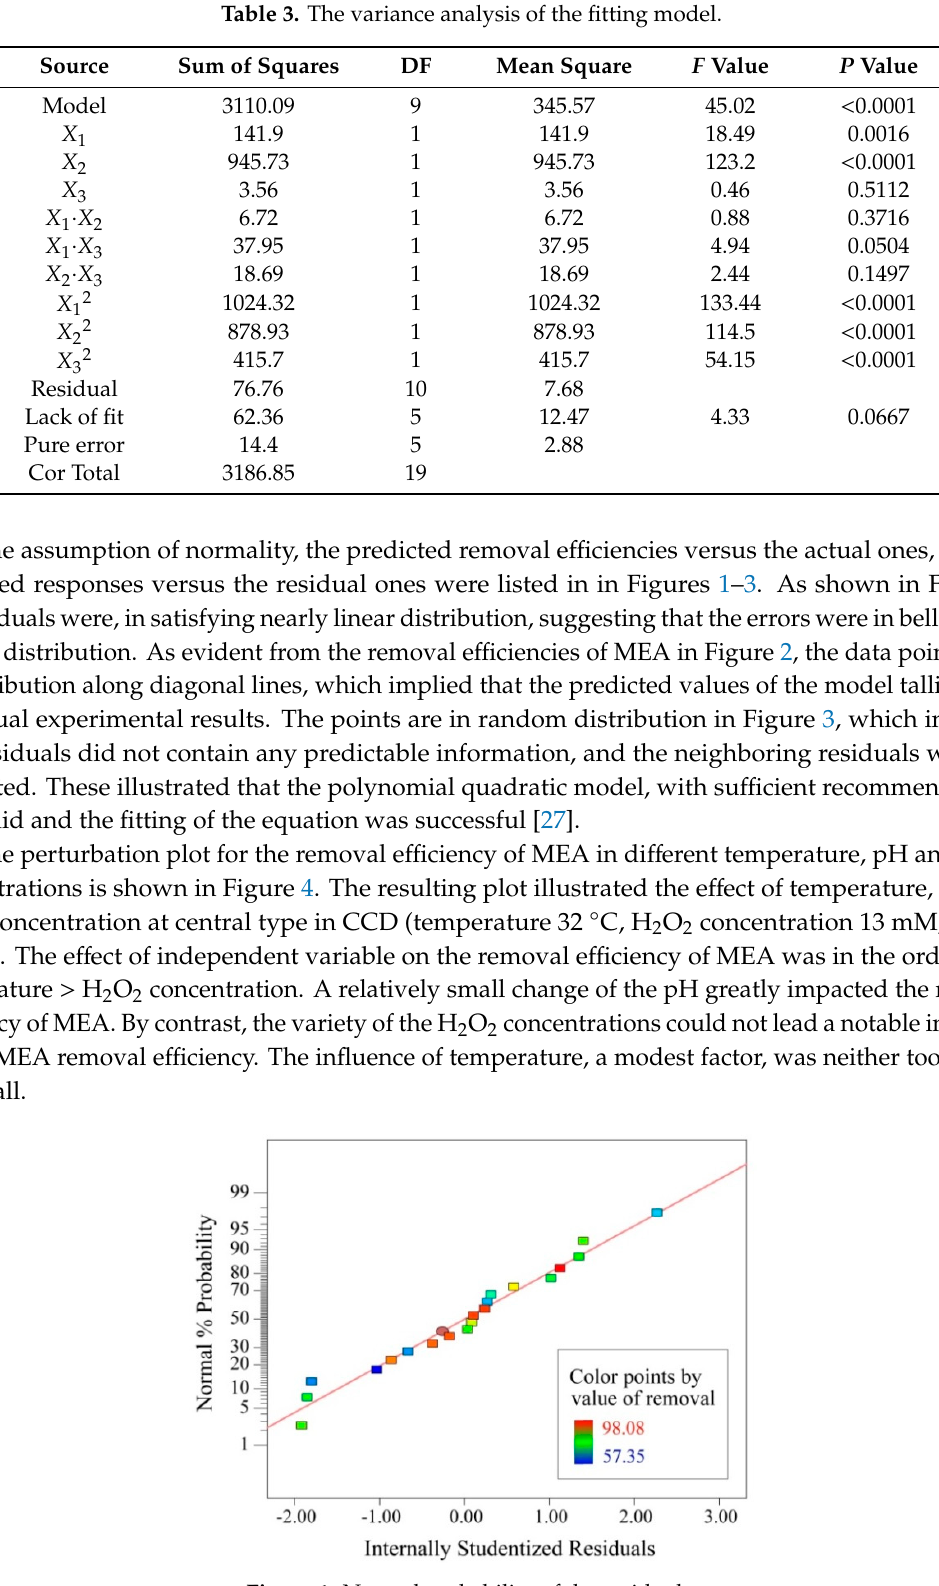
Figure 1. Normal probability of the residuals.